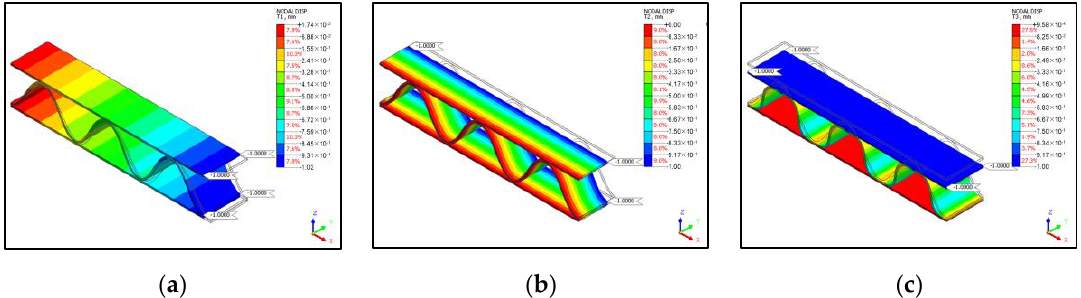
Figure 13. Directional reaction force for the unit cell of A/F-SW corrugated paperboard, they should be list as: ( a ) x -direction; ( b ) y -direction; ( c ) z -direction. Table 4. Reaction forces (N) for 3 sub-problems.